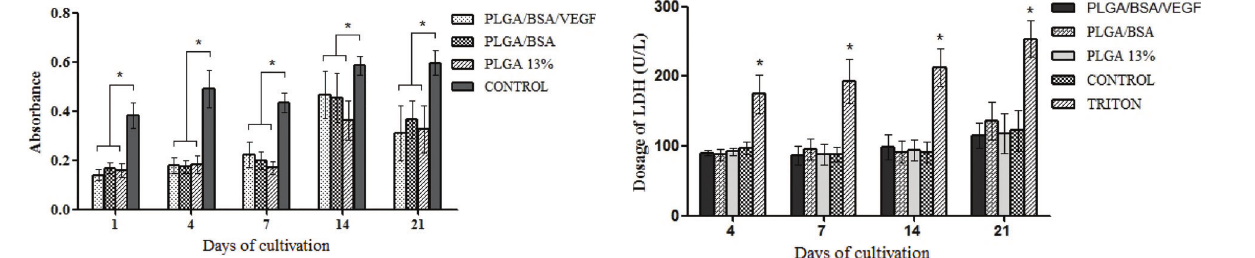
Figure 7. Dosage of lactate dehydrogenase (LDH) in supernatant of primary cultures of human adipose derived stem cells tested on the following scaffold groups: PLGA/BSA/VEGF, PLGA/BSA, 13% PLGA, negative control group (cells seeded directly on the cultiva- tion well plates) and the positive control group (Triton). Data are reported as means ± SD. *P o 0.05 compared to 13% PLGA (repeated measures with post-hoc Bonferroni). PLGA: polylactic- co-glycolic acid; BSA: bovine serum albumin; VEGF: vascular endothelial growth